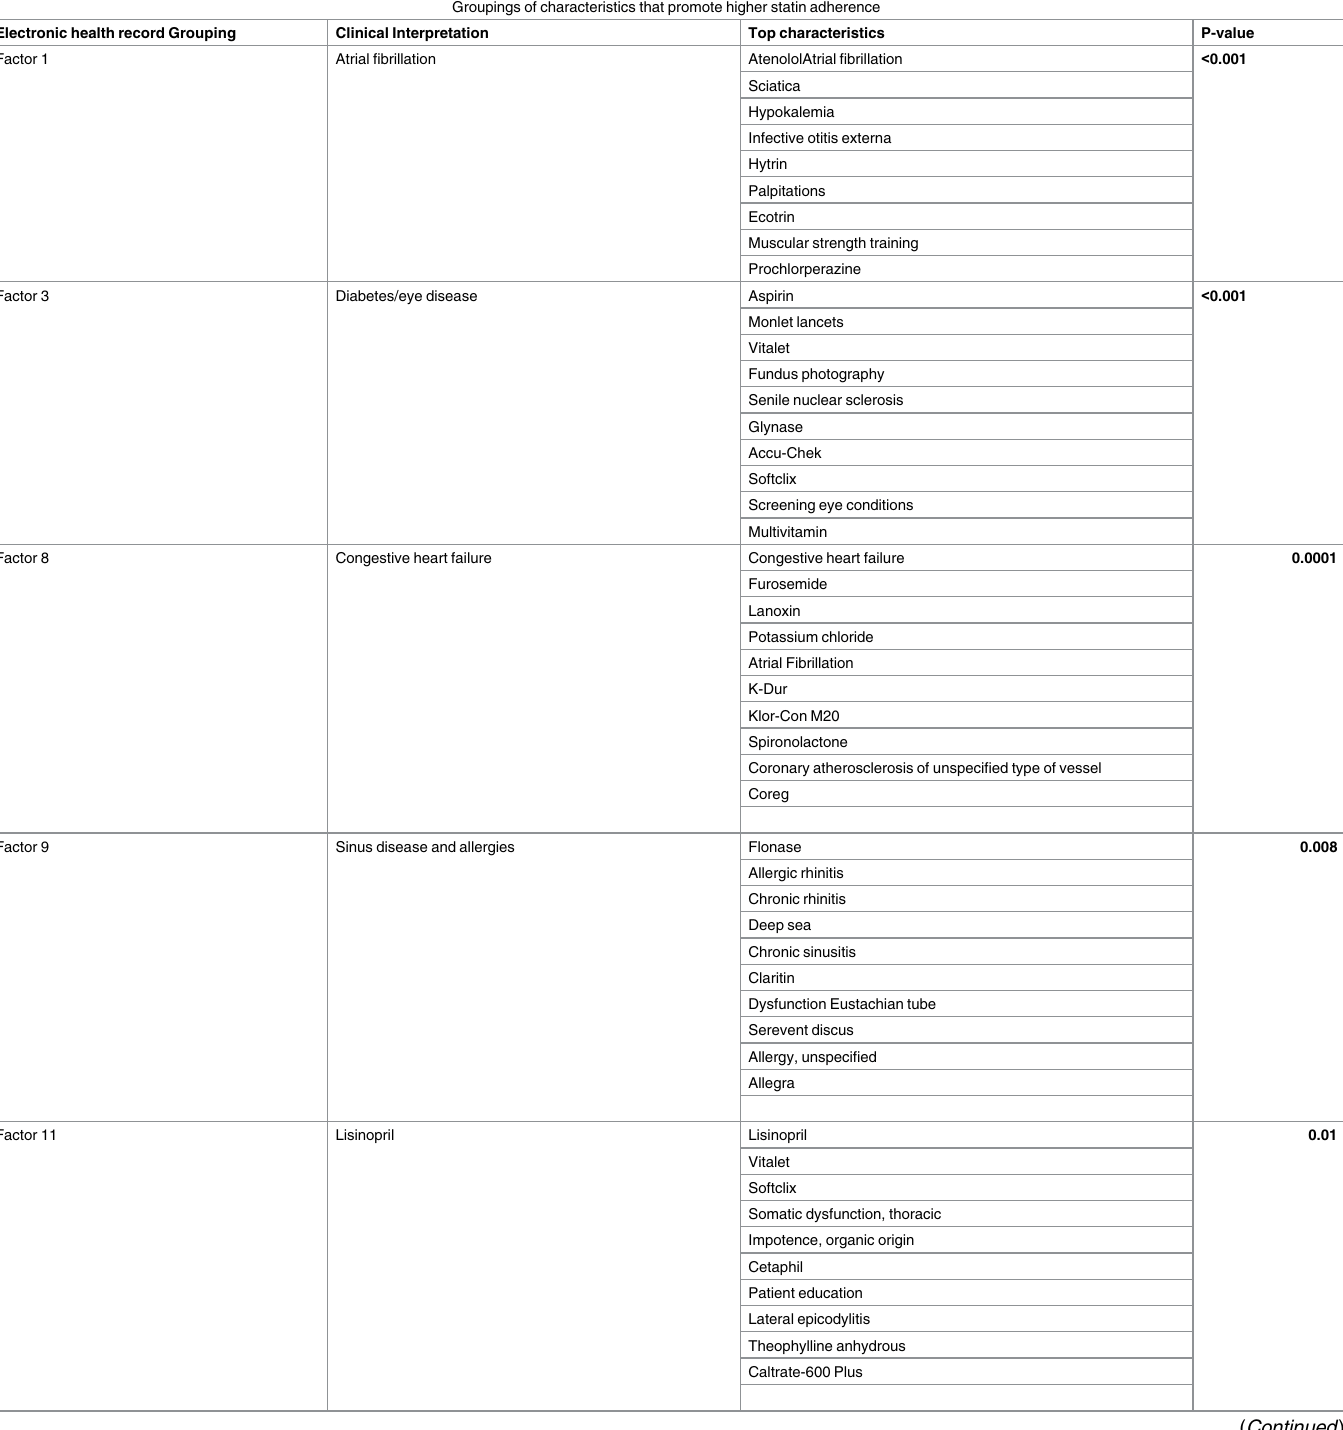
Table 3. Groups of electronic health record codes and their association with higher or lower statin